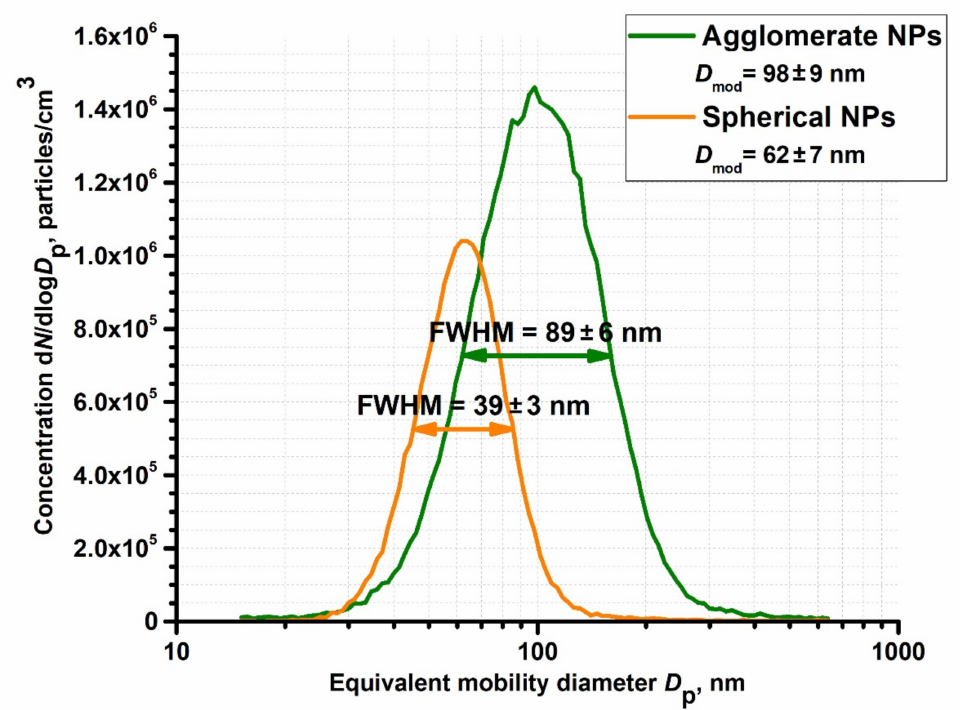
Figure A2. Particle size distributions of agglomerates and spherical NPs measured at the outlet of the coaxial micro nozzle by the aerosol spectrometer (SMPS 3936, TSI Inc., Shoreview, MN, USA). FWHM is the full width at half